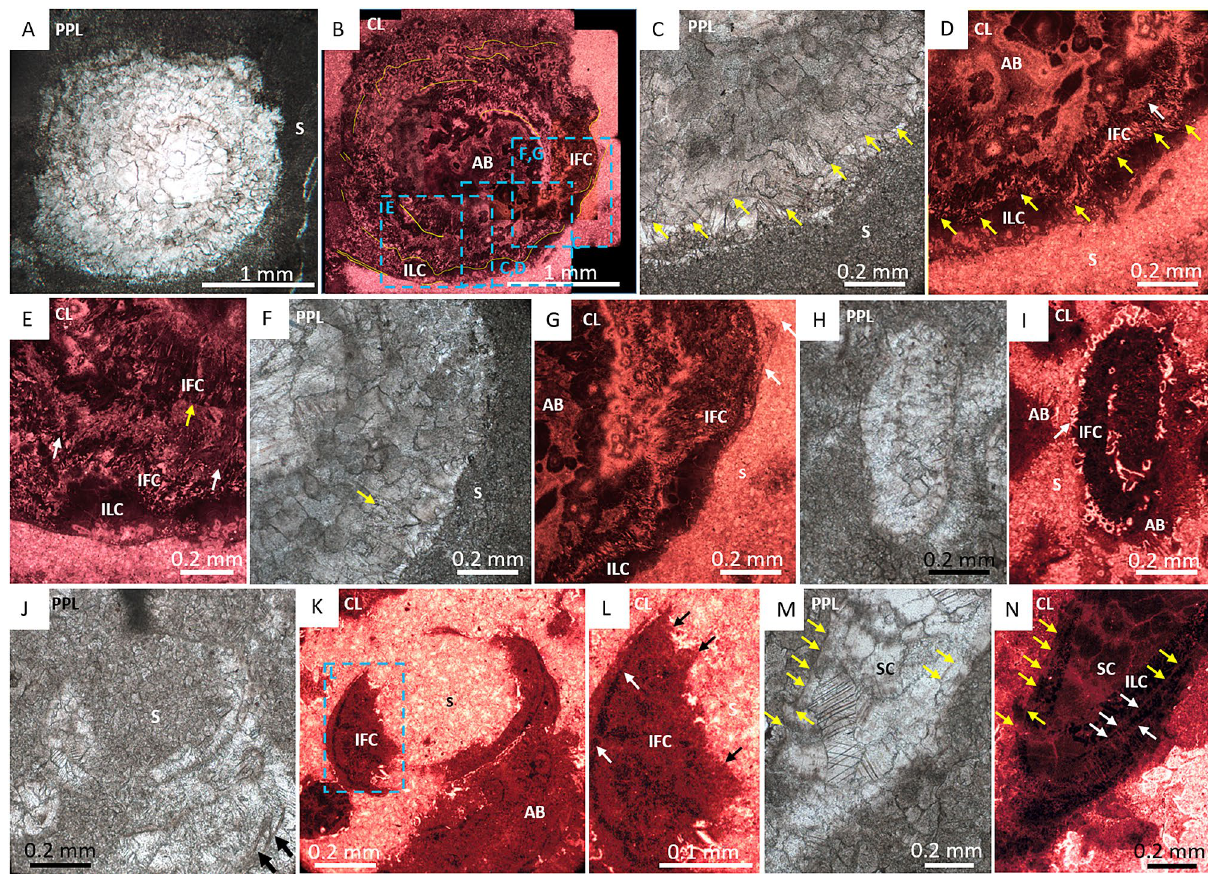
Figure 4. Photomicrographs of Cloudina from Zebra River, Upper Omkyk Member, Nama Group. ( A ) PPL of Cloudina infilled with sparry calcite surrounded by micritic sediment (S). ( B ) CL image of A, with inter-lamina cements (ILC) forming between outer laminae (highlighted in yellow). Pseudomorphed aragonitic botryoids (AB) grow from the laminae, and the inter-funnel cements (IFC) pre-date dull luminescent burial cements with ILC forming between paired laminae. AB infilled the Cloudina tube and S surrounds the tube. ( C ) Inset of B \, PPL showing laminae with a wavy form (yellow arrows). ( D ) CL image of E, laminae highlighted by yellow arrows with same form as PPL image. Nucleation of IFC indicates location of laminae. ( E ) Inset of B, ILC located between two outer laminae (white arrows). IFC nucleate from inner laminae (yellow arrow). ( F ) Inset of B in PPL with lamina visible (arrowed). ( G ) CL of F, where outer laminae shows evidence of ‘spalling’ (arrowed) and infilled by S. ILC situated between laminae and areas of patchy bright luminescence indicate IFC. AB infills the rest of the tube. ( H ) PPL of Cloudina . ( I ) Pseudomorphed aragonitic botryoids (AB) outside Cloudina tube. Botryoids grow from the outer tube wall into the surrounding sediment (S), and have a different luminescence to those inside the tube. Early IFC grows from the inner Cloudina laminae (arrowed). ( J ) PPL of a transverse section of a Cloudina , which is infilled by dolomitised sediment (S) and two sets of broken paired laminae (arrowed) ( K ) CL of J, bright luminescent dolomitised sediment infills the central area of the broken tube. Dull luminescent botryoids (AB) outside the tube. Dull luminescent IFC forms the Cloudina skeleton. ( L ) Inset of K, with evidence of breakage of the non-luminescent ILC (white arrows) and IFC (black arrows). ( M ) PPL of Cloudina tube infilled with sparry calcite (SC) with preserved laminae (yellow arrowed). ( N ) CL of M, with laminae observed in PPL (yellow arrows), laminae shown in CL (white arrows). Laminae are preserved with the same luminescence as the SC infill with a dull cement ILC between the laminae. Figure created in PowerPoint